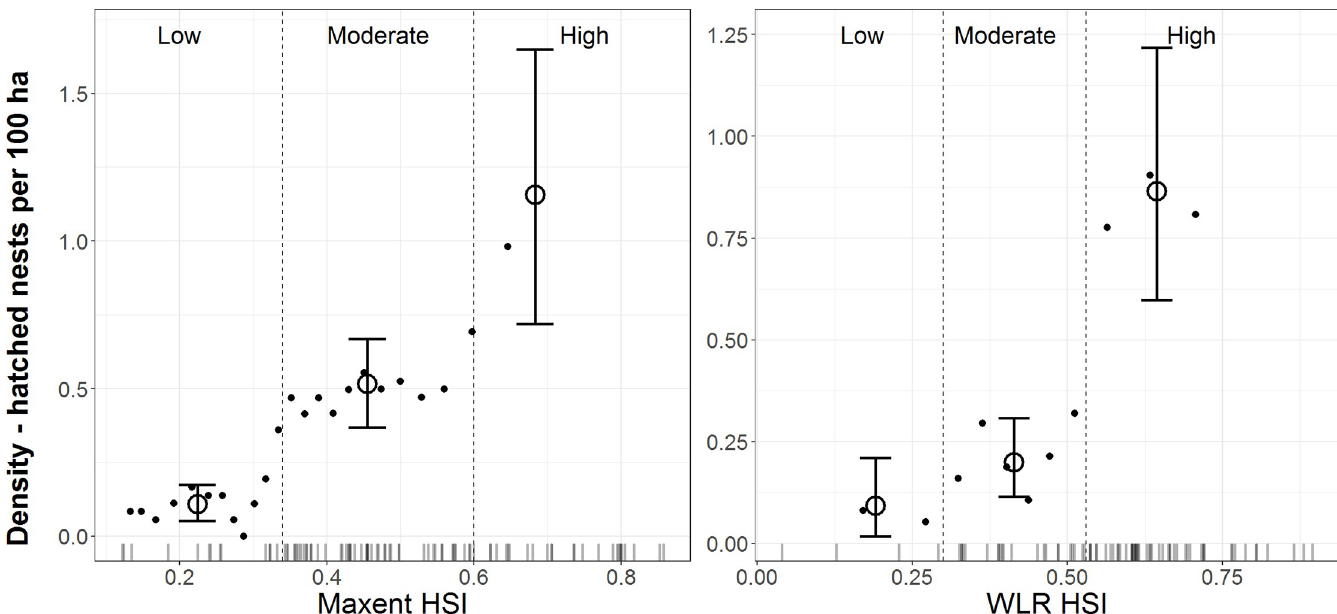
Fig 4. Densities of hatched nests for white-headed woodpeckers along habitat suitability index (HSI) gradients in burned forests. Maxent HSIs quantify relationships with remotely sensed environmental variables only, whereas weighted logistic regression (WLR) HSIs also quantify relationships with field-collected variables. Low, moderate, and high suitability classes are differentiated by two HSI thresholds selected at natural breaks in densities for equal-area moving window bins (small circles) and in the distribution of nest site HSIs (rug bars). Large circles and error bars are density estimates and bootstrapped 95% CIs, respectively, for habitat suitability